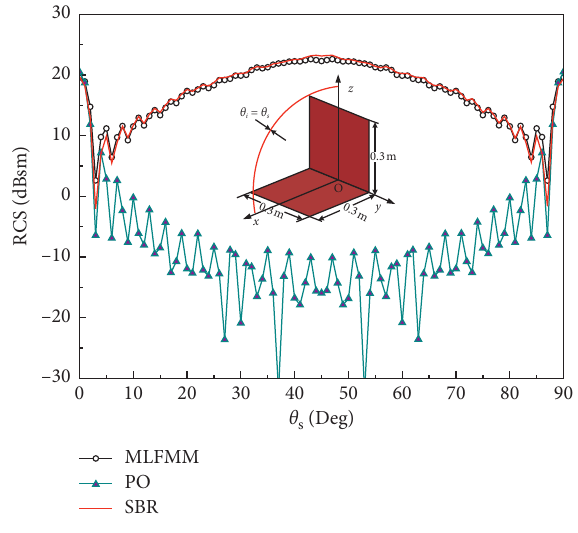
Figure 2: Monostatic RCS of dihedral reflector.